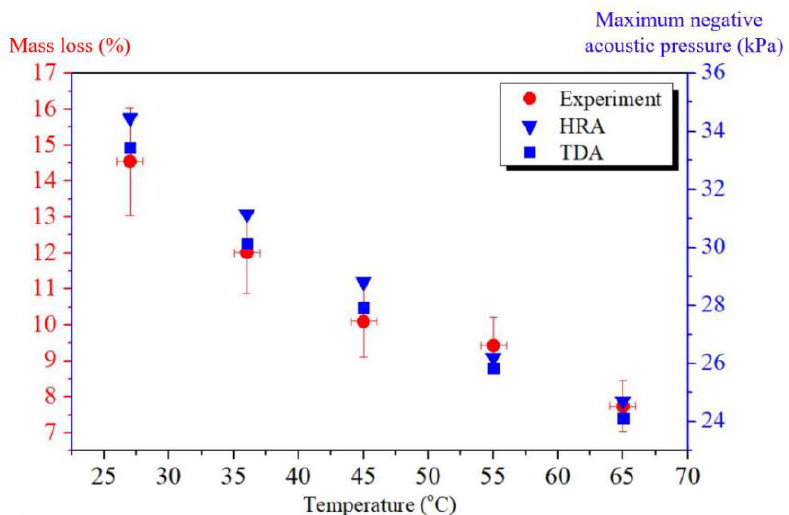
Figure 6. The maximum negative acoustic pressure from the TDA and the HRA compared to the mass loss from the foil corrosion test.